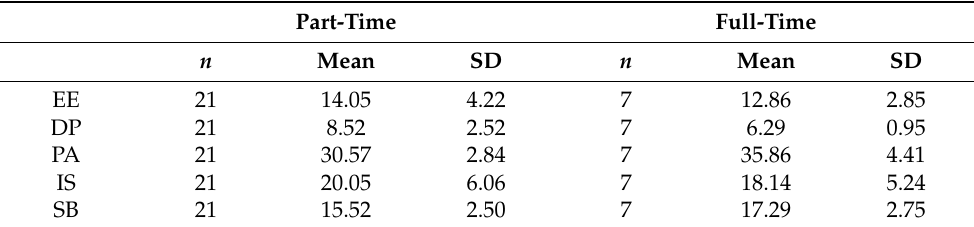
Table 9. Results of the dimensions by work time devoted to university